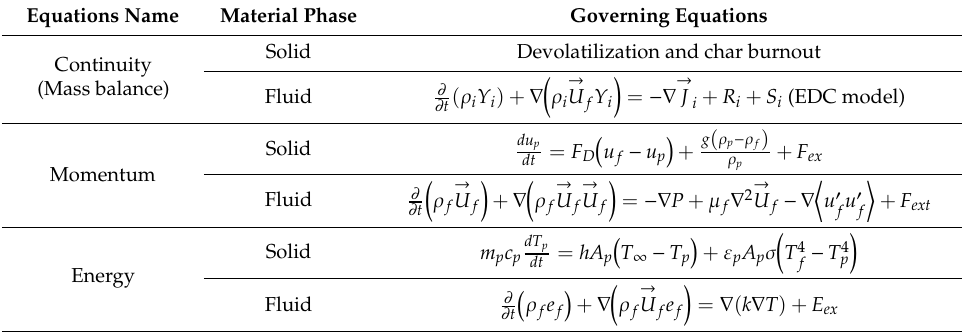
Table 2. Governing equations and the chemical reactions related to the solid combustion [29–31], reproduced with permission from M. Sa ff ari Pour, Producer Gas Implementation in Steel Reheating Furnaces from Lab to Industrial Scale: A Computational Fluid Dynamics and Thermodynamics Approach, Doctoral Thesis, 2016 [32].